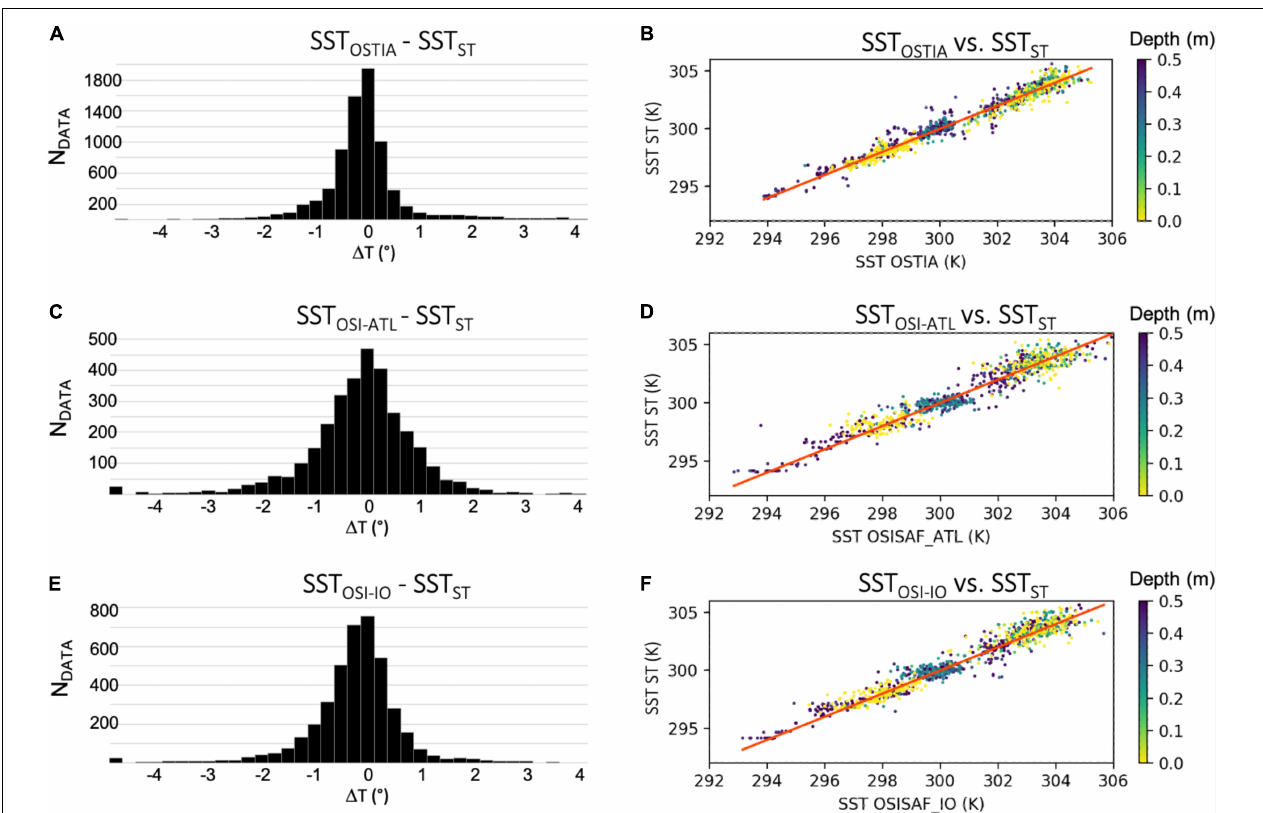
FIGURE 7 | Histogram (left panel) and scatterplot (right panel) of differences between SST data collected by STs (SST ST ) and inferred from the satellite products: (A,B) OSTIA (SST OSTIA ), (C,D) OSI-SAF 206a (SST OSI − ATL ), and (E,F) OSI-SAF IO (SST OSI − IO ), between January 2019–April 2020. Colors in subpanels (B,D) and f indicate the depth of collected ST measurements between 0 and 0.51 m (color scale to the right). The red line in (A–D) corresponds to the 1:1 line.